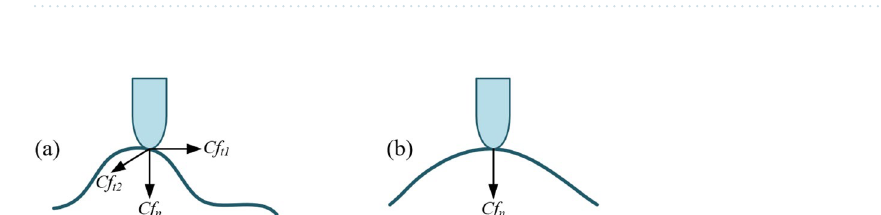
Table 2. Data acquisition sensors.